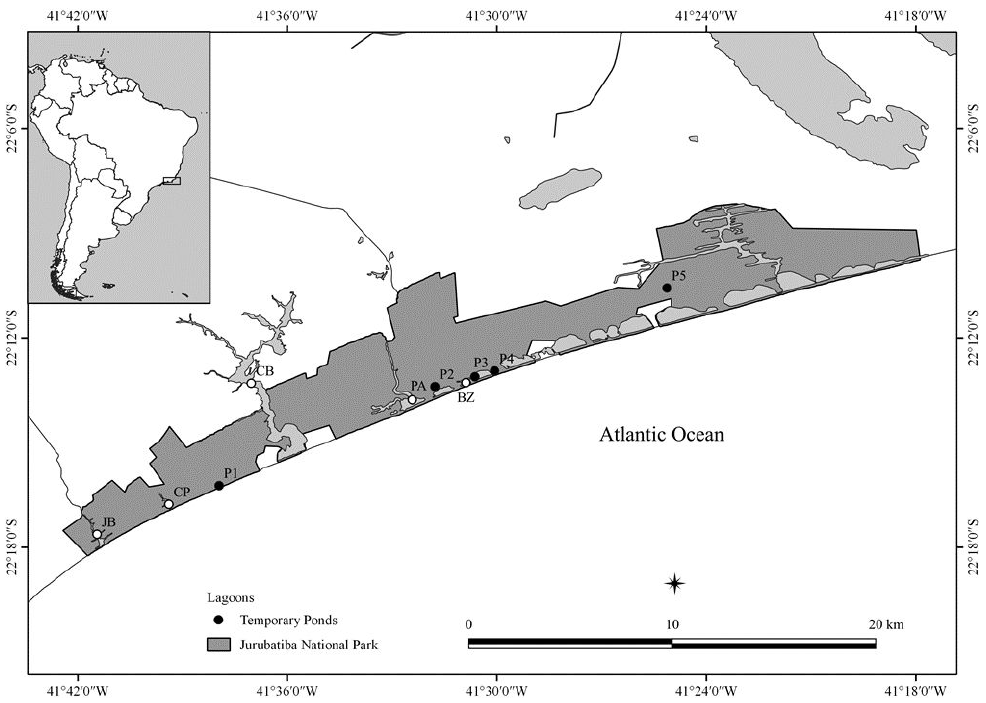
Figure 1. Geographical location of permanent lagoons and temporary ponds located in Jurubatiba National Park, Rio de Janeiro, Brazil. JB = Jurubatiba lagoon; CP = Comprida lagoon; CB = Carapebus lagoon; PA = Paulista lagoon; BZ = Bezerra lagoon; P1 = Pond 1; P2 = Pond 2; P3 = Pond 3; P4 = Pond 4; P5 = Pond